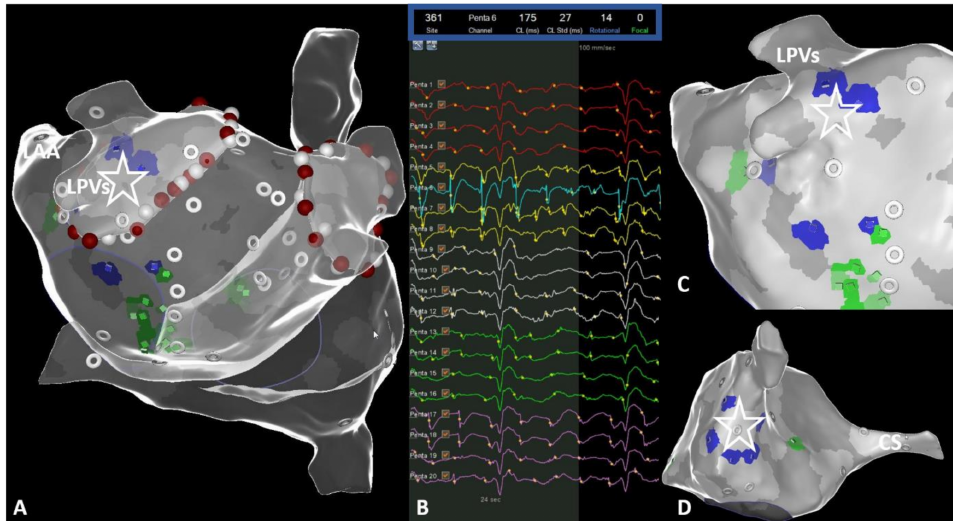
Figure 5. ( A , C , D ) Typical example for rotational activities (blue color) revealed from CARTOFINDER mapping of the left atrium. ( B ) Rotational activation is detected by identifying pan-systolic activation occurring in consecutive electrodes. A pan-systolic activation wave is defined as a series of electro- grams in consecutive electrodes, occupying more than 50% of the local cycle length with a distance of less than 20mm between the starting and ending points of the wave. Two or more such pan-systolic activations occurring are defined as a rotational